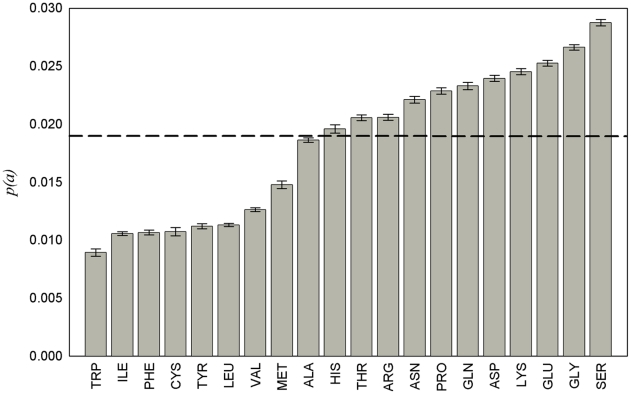
Fraction of disordered amino acid residues for each of the 20 types in the middle part of a protein chain.The dashed line shows the total fraction of disordered residues in the middle part of the protein chain.